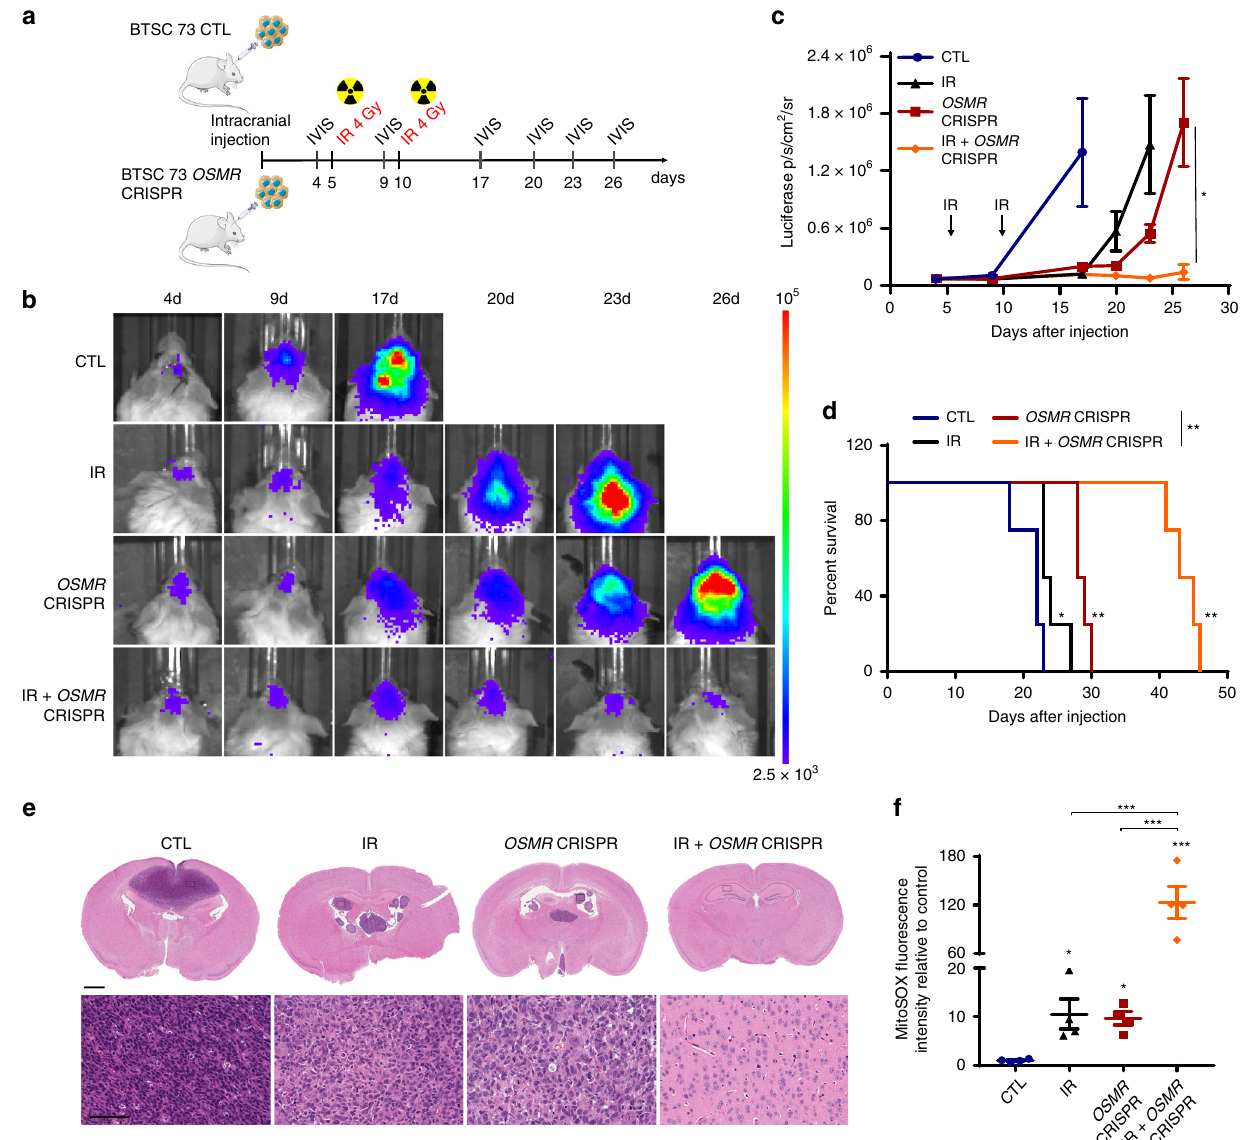
Fig. 7 Suppression of OSMR improves glioblastoma response to therapy. a Schematic diagram of the experimental procedure in which OSMR CRISPR and control BTSC73 (3 × 10 5 cells per brain) were intracranially injected into randomized Fox Chase SCID mice and then treated with or without 4 Gy of IR. b Representative bioluminescence real-time images tracing BTSCs and tumor growth are shown. c Intensities of luciferase signal were quanti fi ed at different time points using Xenogen IVIS software. * p OSMR CRISPR vs. IR + OSMR CRISPR, day 26 = 0.0289; Unpaired two-tailed t -test, n = 4 mice. d Kaplan – Meier survival plot was graphed to evaluate mice lifespan in each group, mice were collected at end stage. * p CTL vs. IR = 0.0311, ** p CTL vs. OSMR CRISPR = 0.0069, ** p CTL vs. IR + OSMR CRISPR = 0.0069, ** p OSMR CRISPR vs. IR + OSMR CRISPR = 0.0067; Two-sided log-rank test, n = 4 mice. e Coronal sections of mouse brains were stained with hematoxylin and eosin on day 22 after injection. Representative images of 3 different tumor sections are shown. Scale bar = 1 mm. Inset scale bar = 0.1 mm. f Tumor sections from OSMR CRISPR and control BTSC73 treated with or without IR (4 Gy) were stained with MitoSOX. The fl uorescent intensity was quanti fi ed using ImageJ software. *** p < 0.0001 for each pairwise comparison except: * p = 0.0215, * p = CTL vs. OSMR CRISPR CTL vs. IR 0.0129; One-way ANOVA followed by Tukey ’ s test for multiple comparisons, n = 4 different tumor sections. Data are presented as the mean ± exposed to IR or mice receiving OSMR KD BTSCs were at end- exposure to IR combined with KD of OSMR signi fi cantly point at 23 and 26 days, respectively. Strikingly, mice receiving a enhanced ROS levels whereby we observed a 120-fold increase in combination of OSMR KD BTSCs and IR survived past 40 days the fl uorescence signal intensity compared to only ~10-fold in (Fig. 7b – e). To determine whether OSMR KD affects ROS gen- either irradiated control tumors or OSMR KD tumors in the eration following exposure to IR in vivo, mitochondrial super- absence of IR (Fig. 7f and Supplementary Fig. 7b). In conclusion, oxide levels were assessed via staining of the patient-derived our results established that KD of OSMR increases cellular ROS tumor sections with MitoSOX. KD of OSMR induced a signi fi cant levels, promotes BTSC death, sensitizes the response of BTSCs increase in ROS levels compared to control as detected via ana- and brain tumors to IR, and most importantly extends animal lysis of MitoSOX fl uorescence signal intensity. Importantly, lifespan.